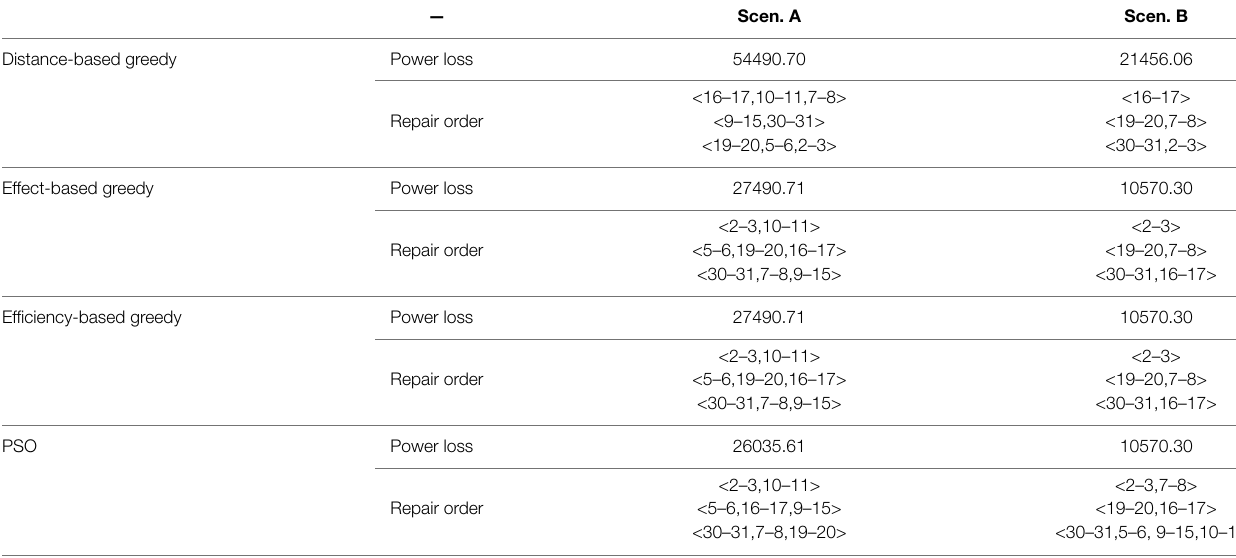
TABLE 1 | Repair strategy for a single scenario.